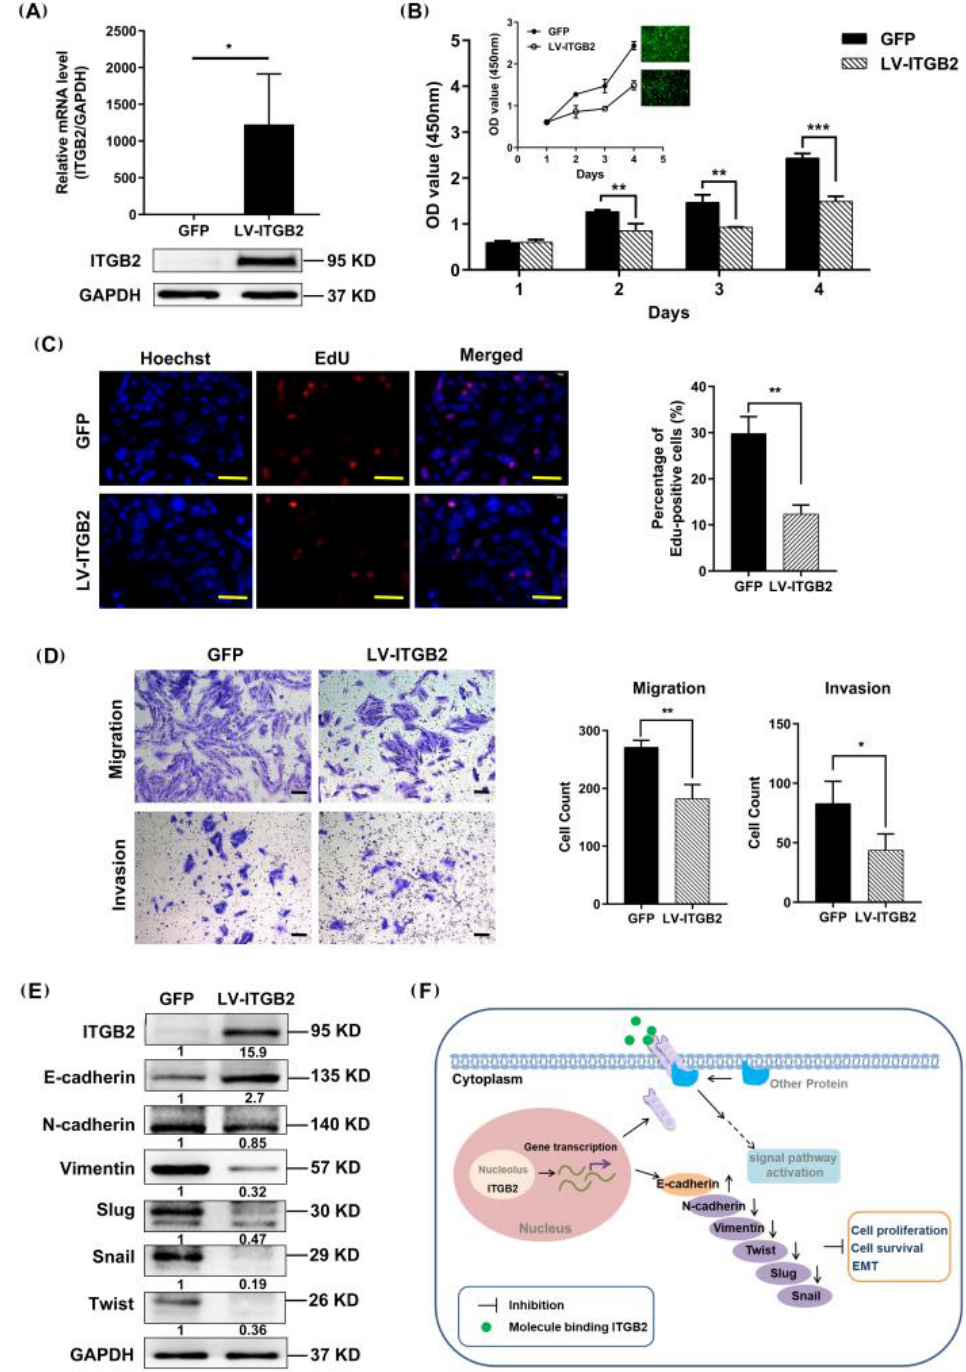
Figure 4. ITGB2 inhibits the proliferation, migration, and invasion of NSCLC cells in vitro. ( A ) ITGB2 expression at the mRNA level and protein level in H1792 cells. ( B ) Cell viability was detected by CCK-8 assay (** p < 0.01, *** p < 0.001), and the optical density (OD) absorbance values at 450 nm were measured using a microplate reader, embodying the proliferation capacity of the cells. ( C ) Cell proliferation ability was detected by the EdU assay, scale bars: 50 µ m (** p < 0.01). ( D ) The migration and invasion of H1792 cells were evaluated by a Transwell assay, scale bars: 100 µ m, (* p < 0.05, ** p < 0.01). ( E ) The Epithelial–mesenchymal transition markers were detected by Western blot assay in H1792 cells. ( F ) Schematic diagram of the potential mechanisms of ITGB2-mediated inhibition of tumorigenesis in NSCLC. All representative images from at least three independent experiments. * P < 0.05, ** P < 0.01, *** P < 0.001. 4. Discussion NSCLC is the most common type of lung cancer, representing about 85% of lung cancer cases [26]. In recent years, although a number of studies have been conducted to explore the treatment and mechanism of NSCLC, the overall survival of patients is still less than 5 years [27]. Thus, it is particularly important to find new molecular markers for the prognosis of lung cancer patients. In this study, we proved that the expression of ITGB2 in NSCLC tissue was significantly reduced compared with adjacent lung tissues and was related to the stage of NSCLC patients. In addition, the low expression of ITGB2 was associated with worse overall survival. All these results suggested that ITGB2 may be a molecular diagnostic target or therapeutic marker for LUAD and LUSC patients. According to previous studies, ITGB2 is related to the occurrence of many diseases, including carotid atherosclerosis, necrotizing enterocolitis, and cancer. The expression of ITGB2 was upregulated in atheroma plaque compared with intact tissue and involved in the development of carotid atherosclerosis [28]. Moreover, ITGB2 deficiency causes the